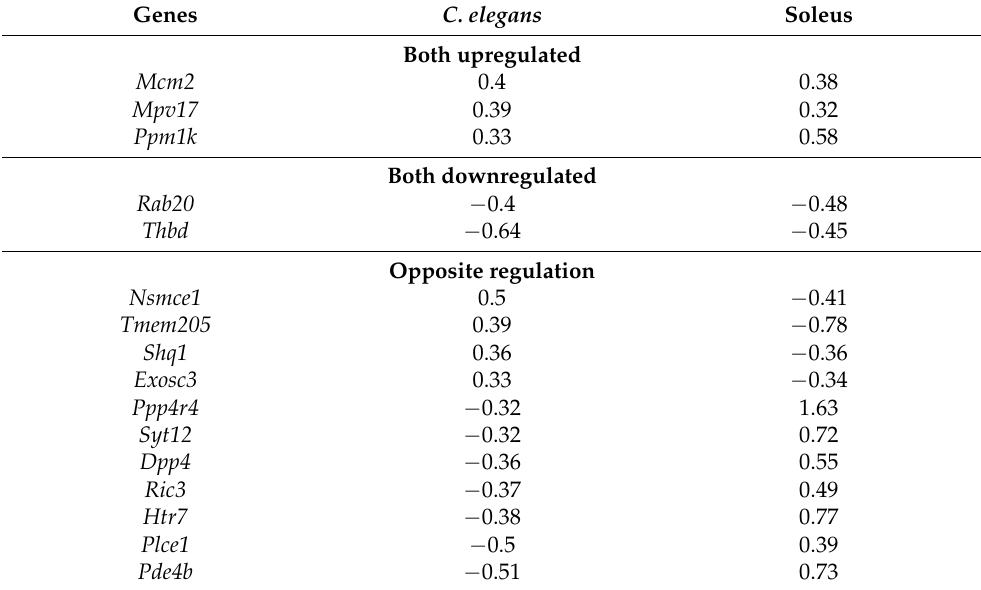
Table 2. DEGs shared between space flown C. elegans and soleus muscle and their direction of regulation. Values shown are Log2 fold change (FC). Genes C.